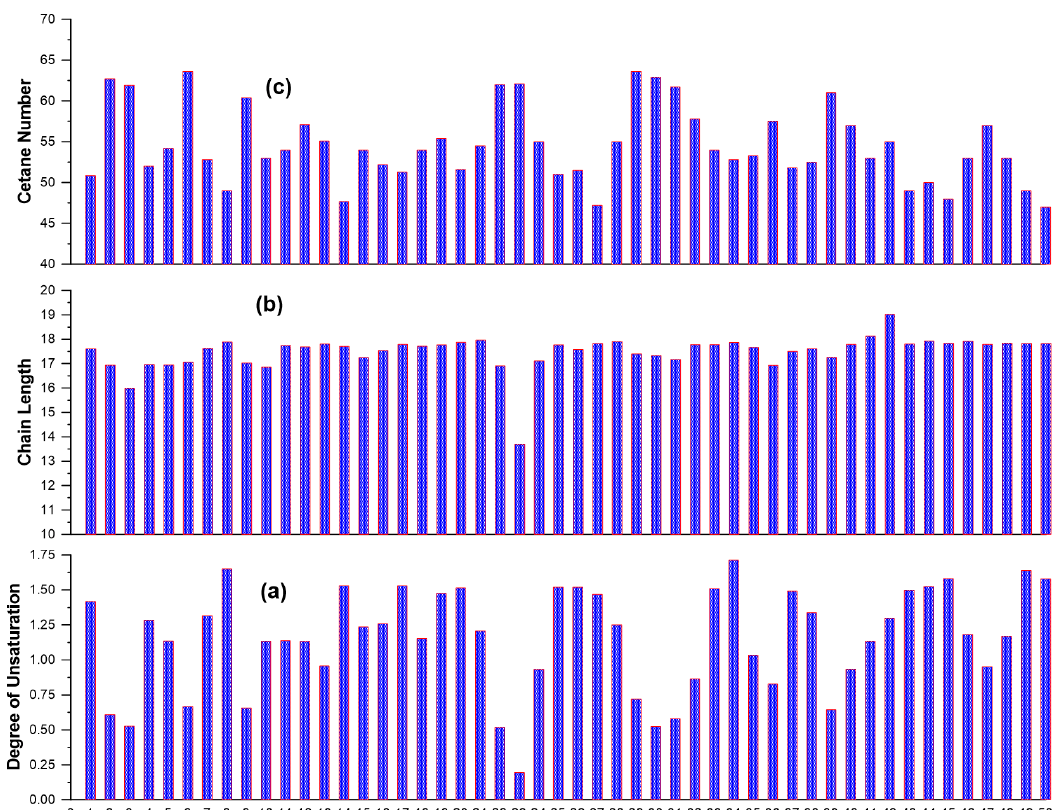
Figure 4. Degree of unsaturation ( a ), chain length ( b ) and cetane number ( c ) for the 50 methyl esters in the data set (CN values are experimental and are also provided in Table 4; DU and CL represent weighted averages based on the experimentally obtained FA compositions. For the DU, the calculation is further based on the usually employed approach of accounting unsaturated FAs of the form Cxx:y with a weight percentage of